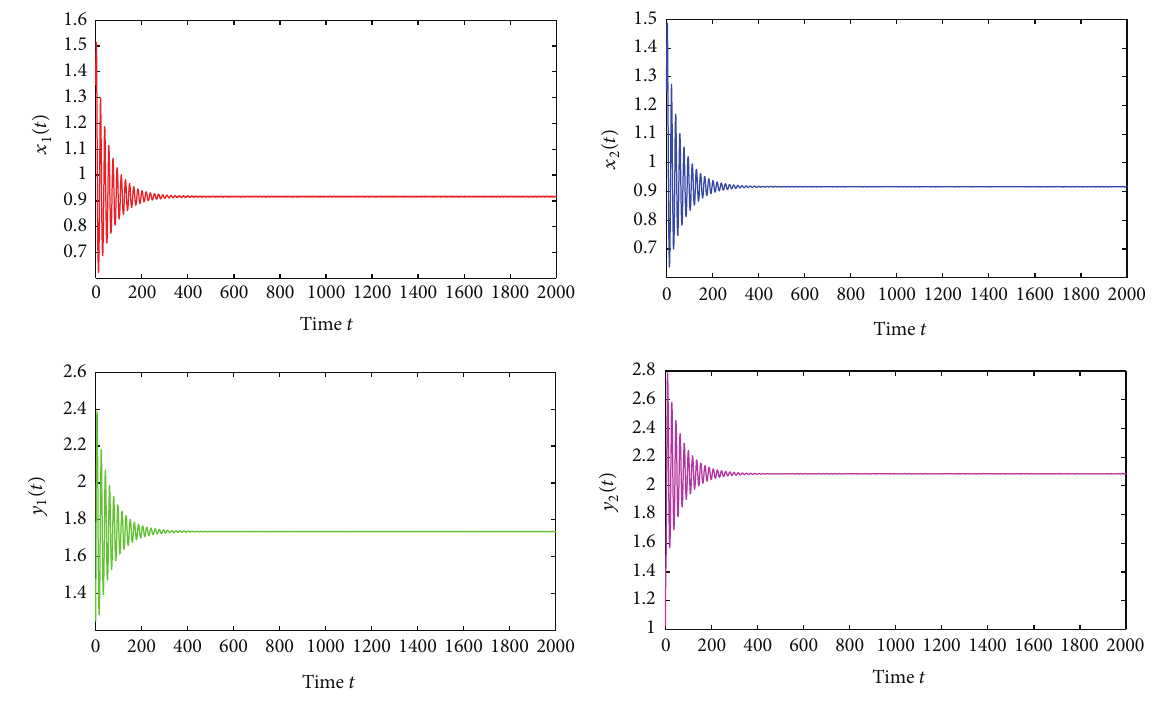
Figure 13: The track of the states 𝑥 1 , 𝑥 2 , 𝑦 1 , 𝑦 2 for 𝜏 = 2.7500 < 𝜏 0 = 3.1043 .